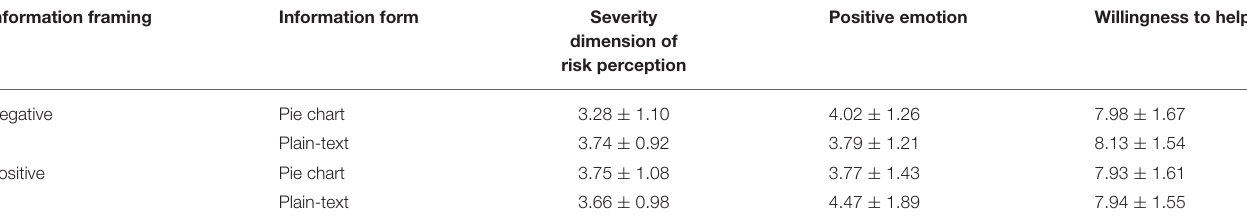
TABLE 2 | Descriptive statistics of risk perception, positive emotion, and willingness to help of participants in different information priming conditions ( M ± SD ). Information